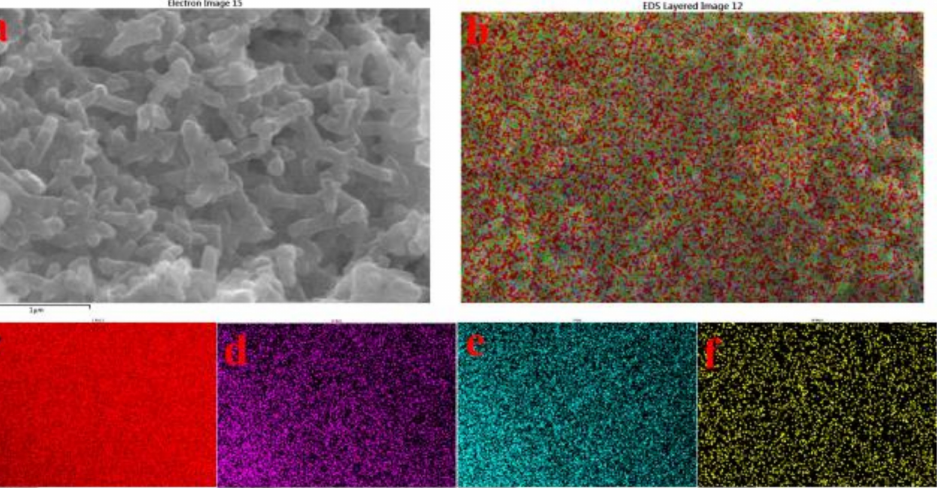
Figure 4. ( a ) FESEM image and ( b ) EDX elemental mapping of WS 2 -PANI-5 nanocomposite on a Si wafer for the following elements: ( c ) C, ( d ) Cl, ( e ) Sulphur, and ( f )